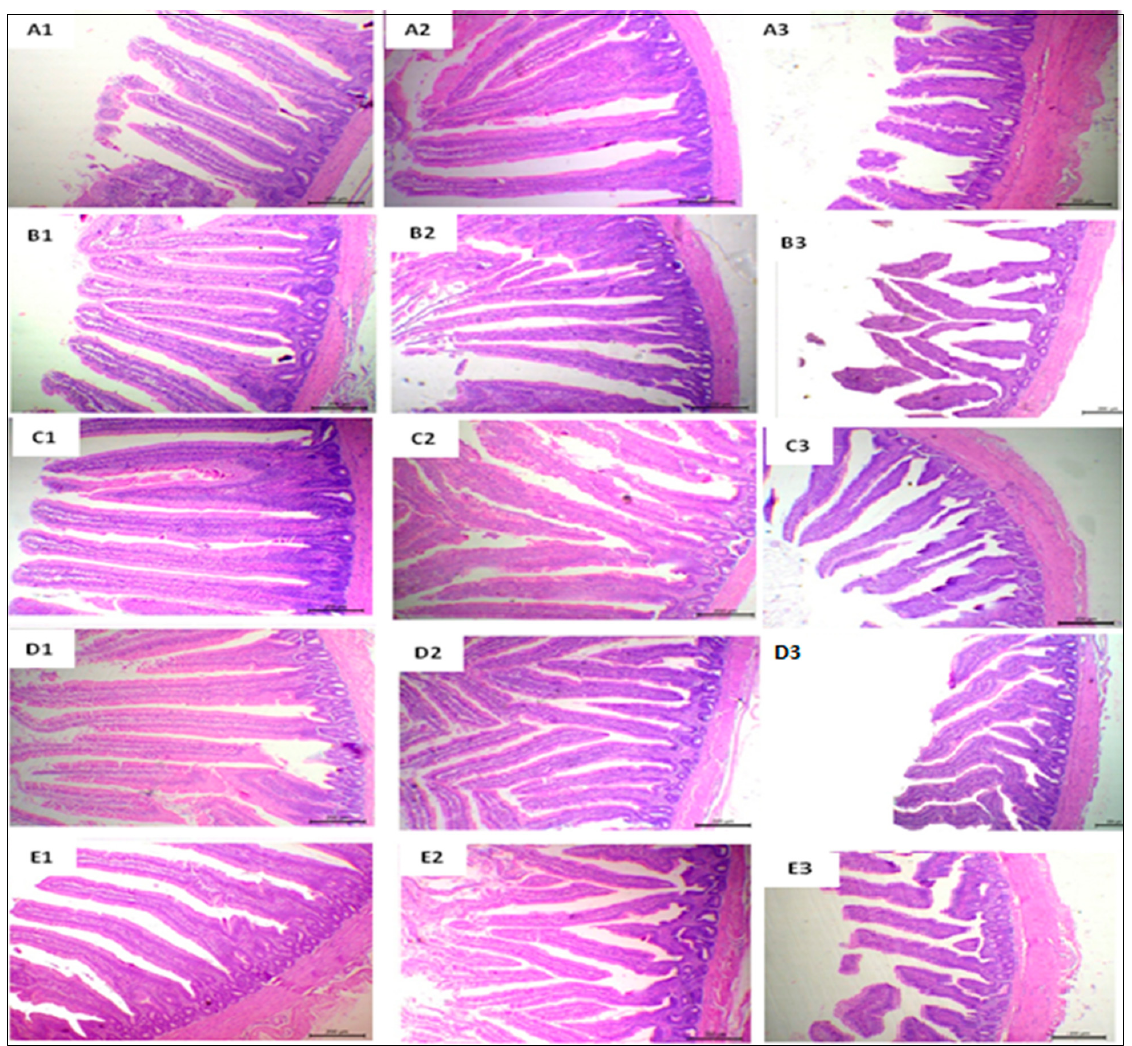
Figure 2. Representative photomicrograph of H&E-stained small intestine sections of broiler chickens in 40 × magnification. Duodenal sections from SPC0 showed normal intestinal villi with a free lumen ( A1 ); those from SPC0.25 group showed a mild increase in villus height ( B1 ); sections from SPC0.5–1 groups revealed markedly thin, tall, and separate villi with mild goblet cell proliferation, increased sizes, and rows of enterocytes with arranged lamina propria ( C1 , D1 , E1 ). Jejunal segment sections of SPC0 showed free lumina with nearly normal villus structures ( A2 ), while sections from the SPC0.25 group showed a small increase in villi length ( B2 ). Jejunum segments from SPC0.5 − 1 groups showed closely packed villi with a marked increase in their length and markedly serrated surfaces with goblet cell metaplasia ( C2 , D2 , E2 ). Ileal segment sections from basal treatment showed tongue-shaped villi with a different height ( A3 ); sections from the SPC0.25 group exhibited normal histology ( B3 ); the sections from the SPC0.5 and SPC0.075 groups showed relatively increased villus height ( C3 , D3 ); those from the SPC1 diet group showed normal villi ( E3